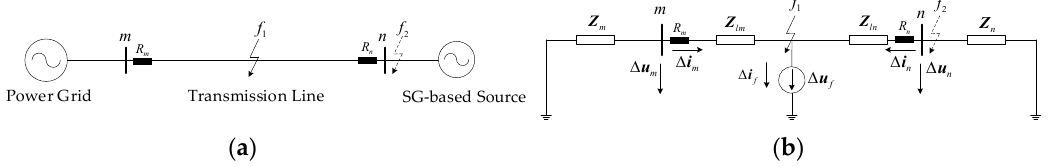
Figure 1. Model of the conventional transmission line and its fault component network : ( a ) transmission line model; and ( b ) fault component network.